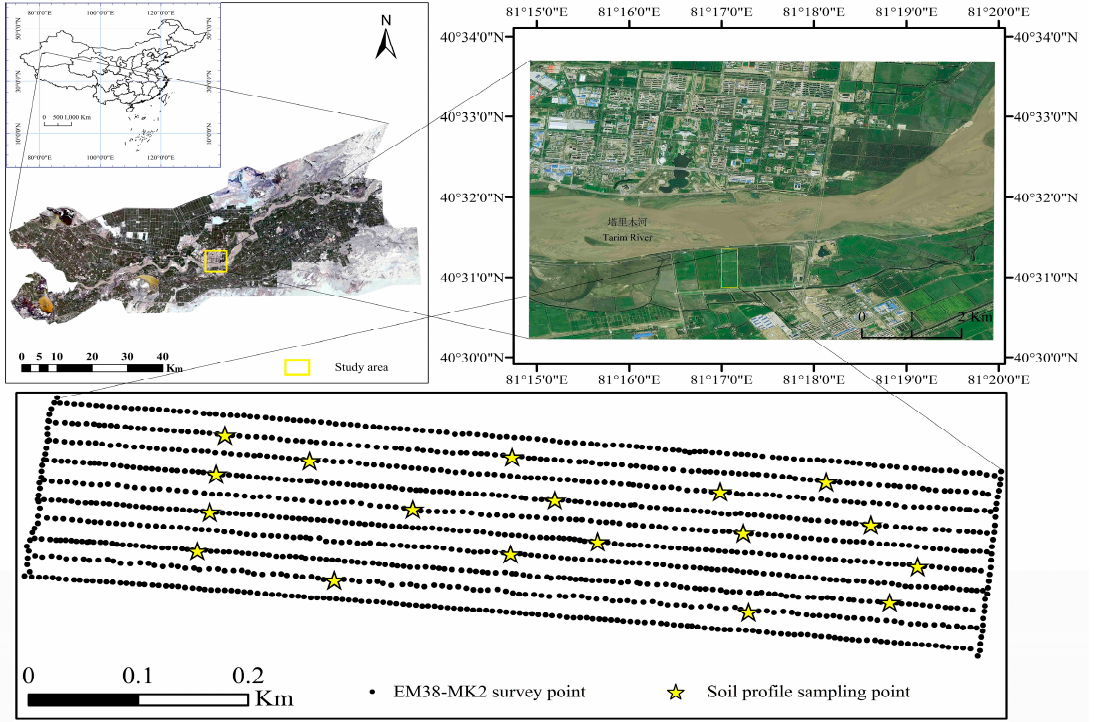
Figure 1. Geographical location of experimental area and distribution of EM38-MK2 survey